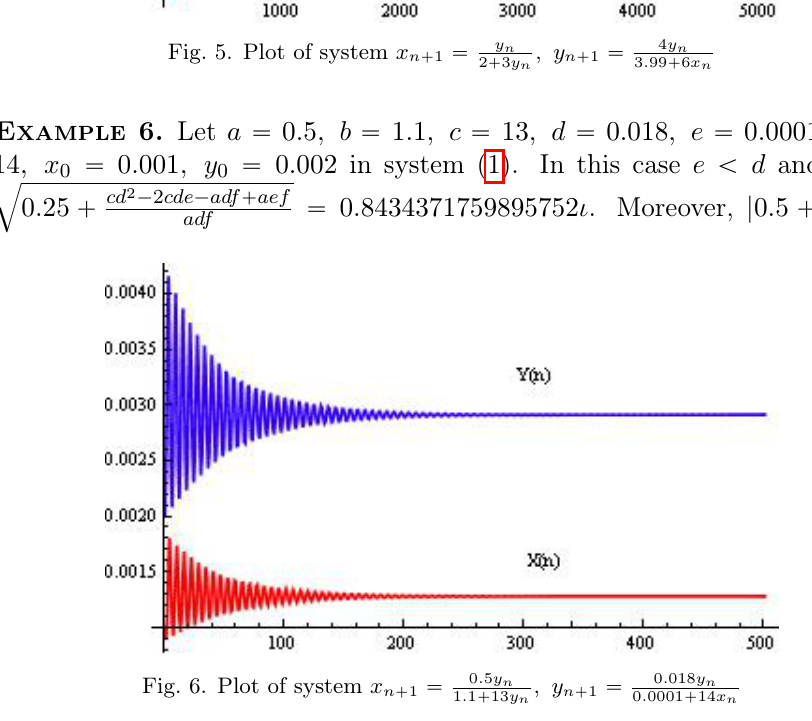
Fig. 6. Plot of system x n ` 1